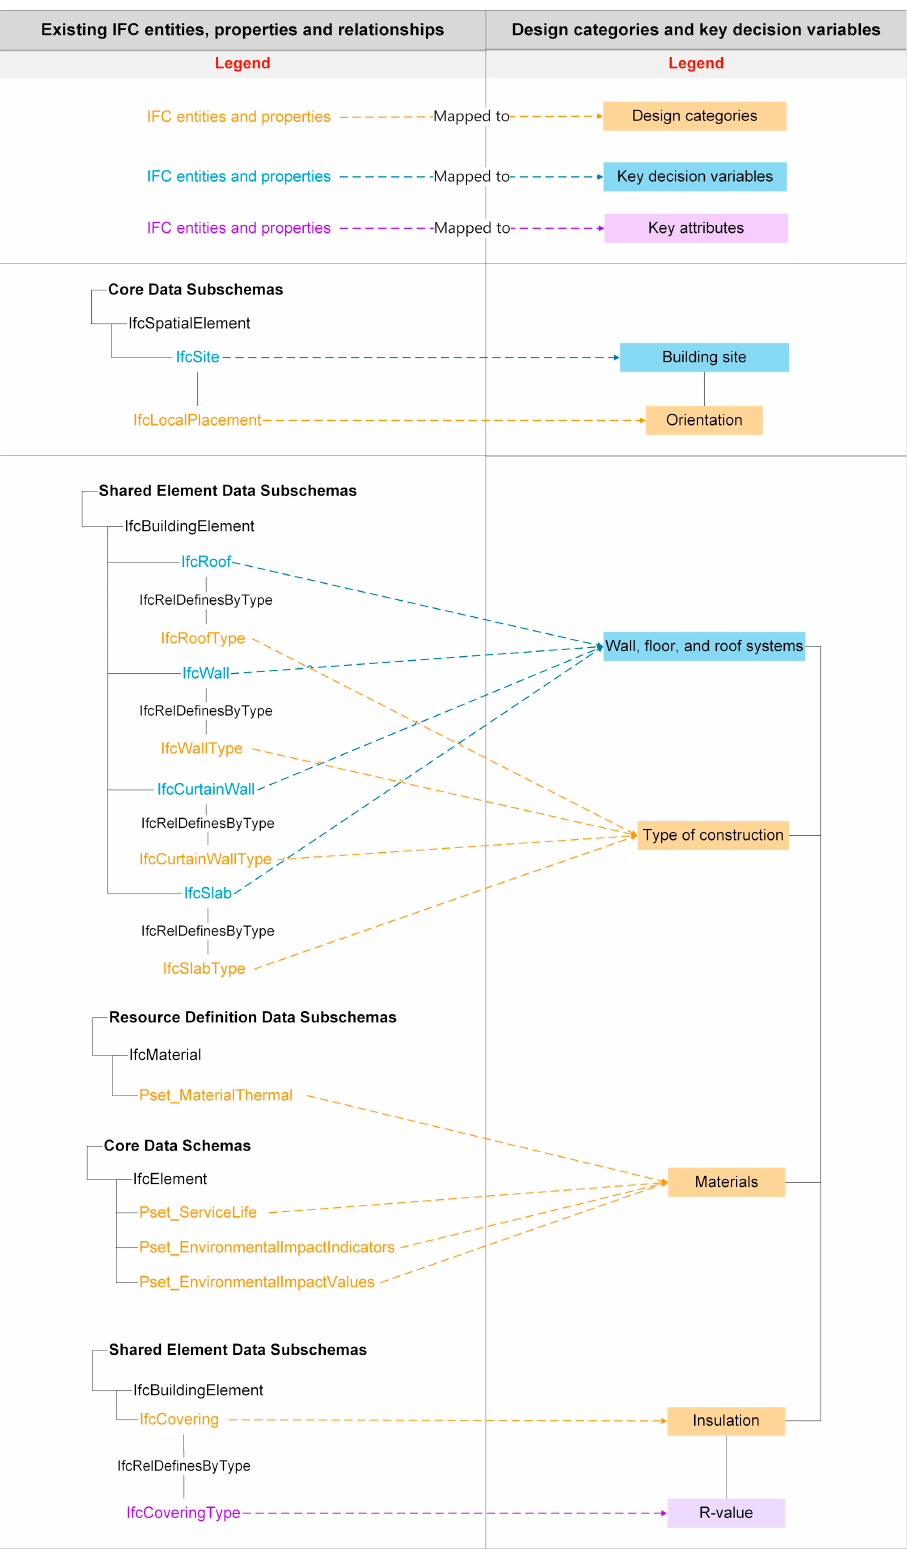
Figure 8. Existing IFC entities, properties, and relationships representing design categories and key decision variables affecting net-zero-carbon building outcomes at design stage.